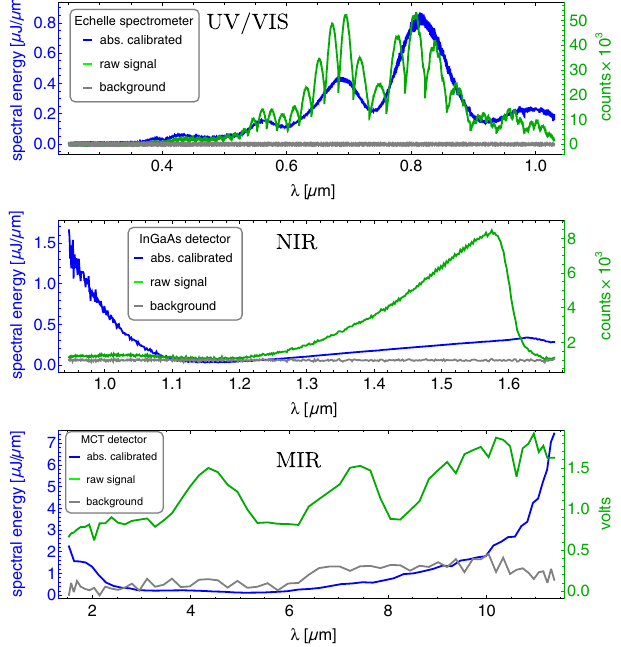
FIG. 18. Typical spectral measurement of coherent to incoher- ent TR radiation: The absolutely calibrated and bandwidth normalized partial spectra, depicted in blue, are determined using Eq. (20). The green curves show the raw signal acquired by the associated detectors. The gray curves, associated also with the right axis, show the background signal acquired by removing the TR screen and SM collimator from the beam